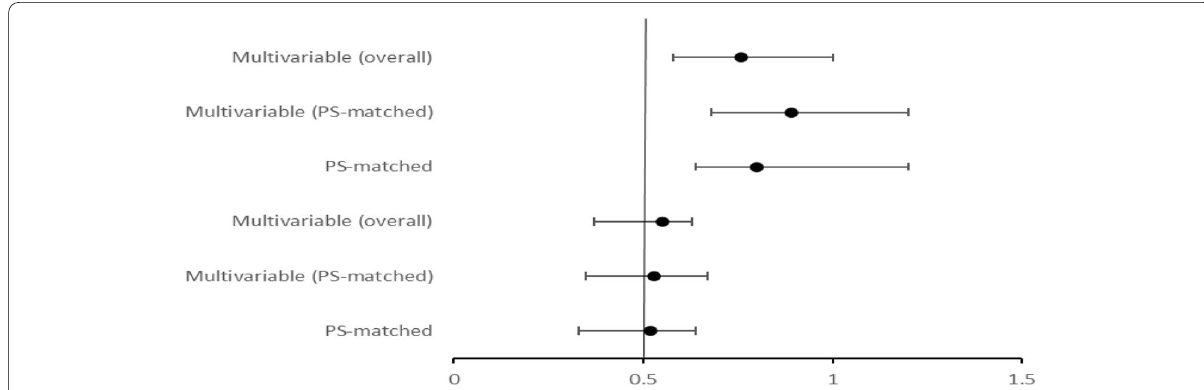
Fig. 2 Forest plot demonstrating the odds ratio and 95% confidence interval for in-hospital mortality with statin use depicting primary endpoint and secondary